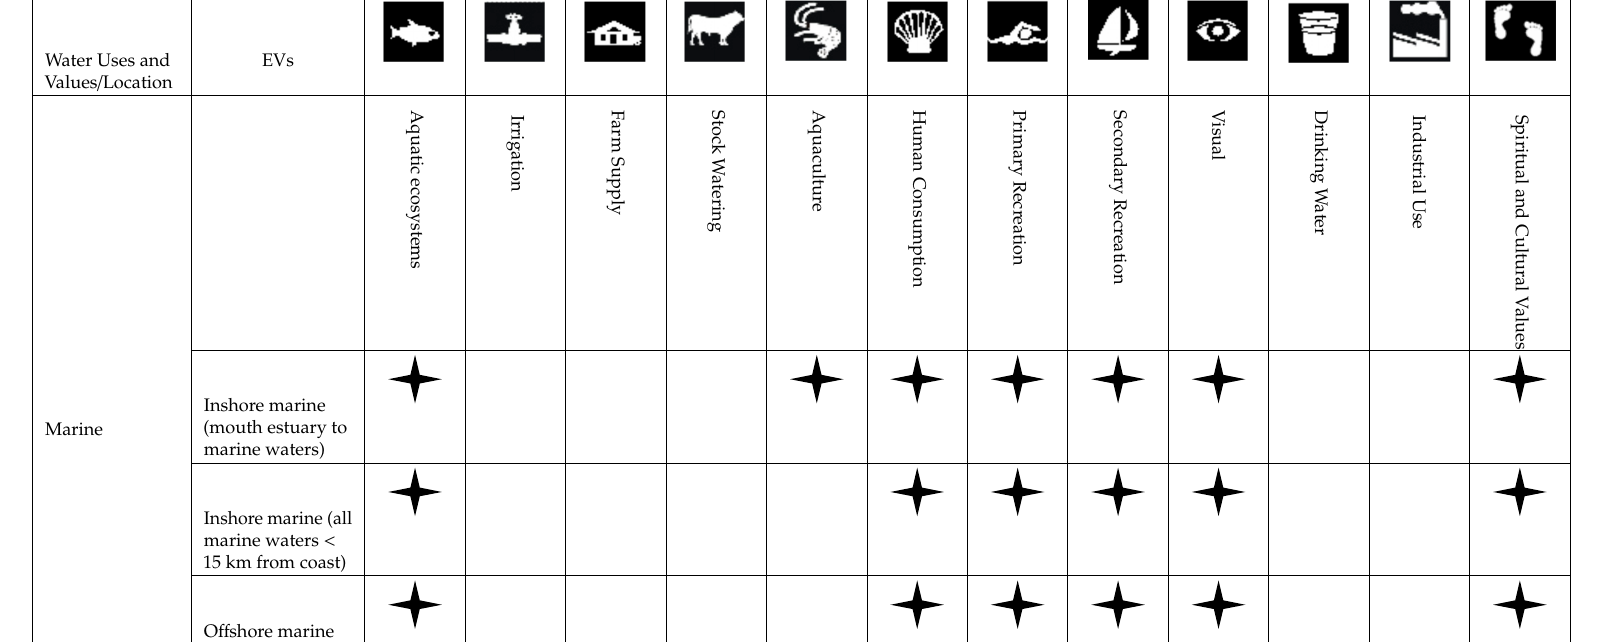
Table A1. List of EVs * Summarised for the Tully Basin EVs (as a result of this current research.